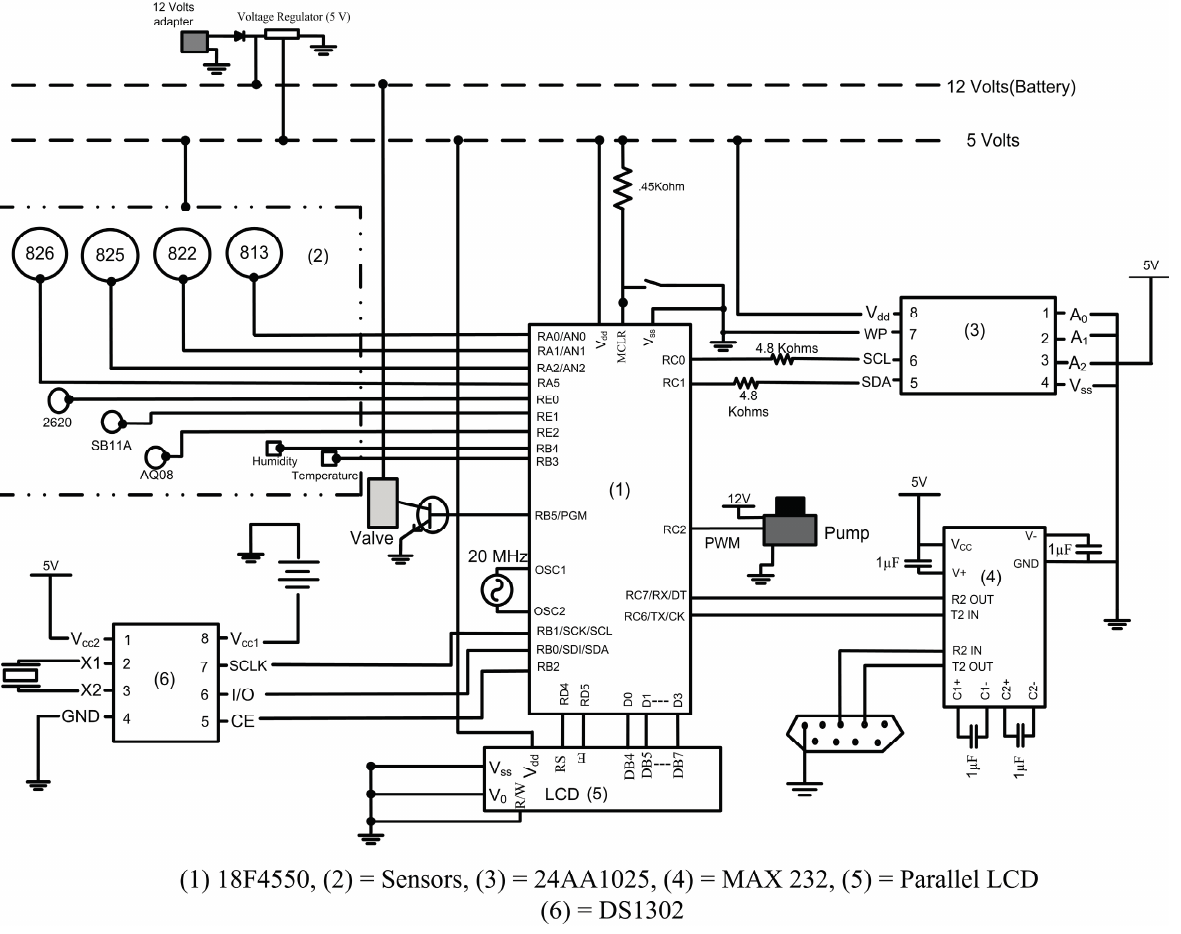
Figure 4. Electronic circuit designed for automation of the customized gas sensor